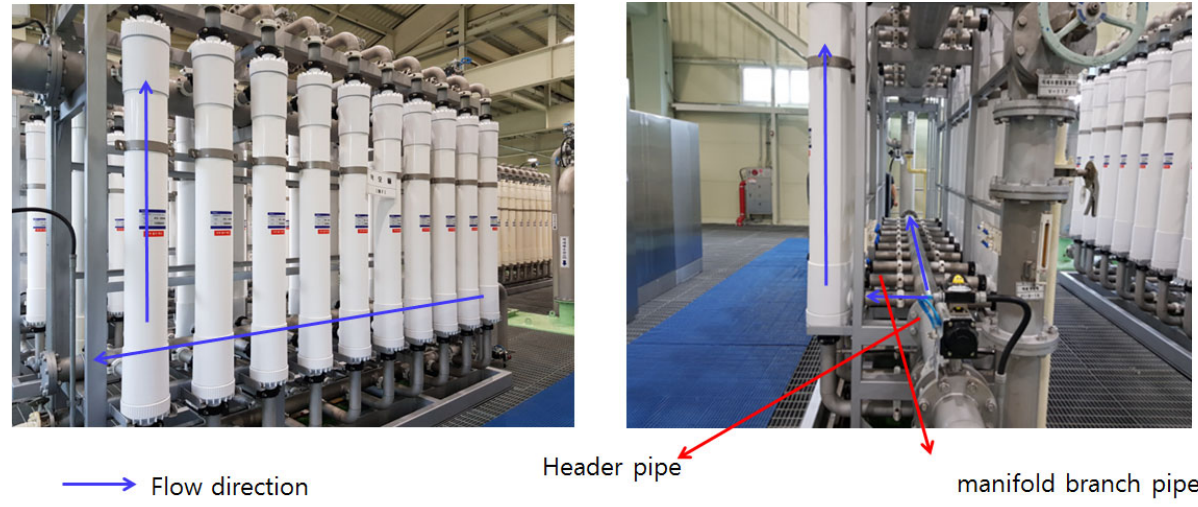
Figure 1. Actual parallel ‐ arrayed low ‐ pressure membrane module for drinking water treatment.